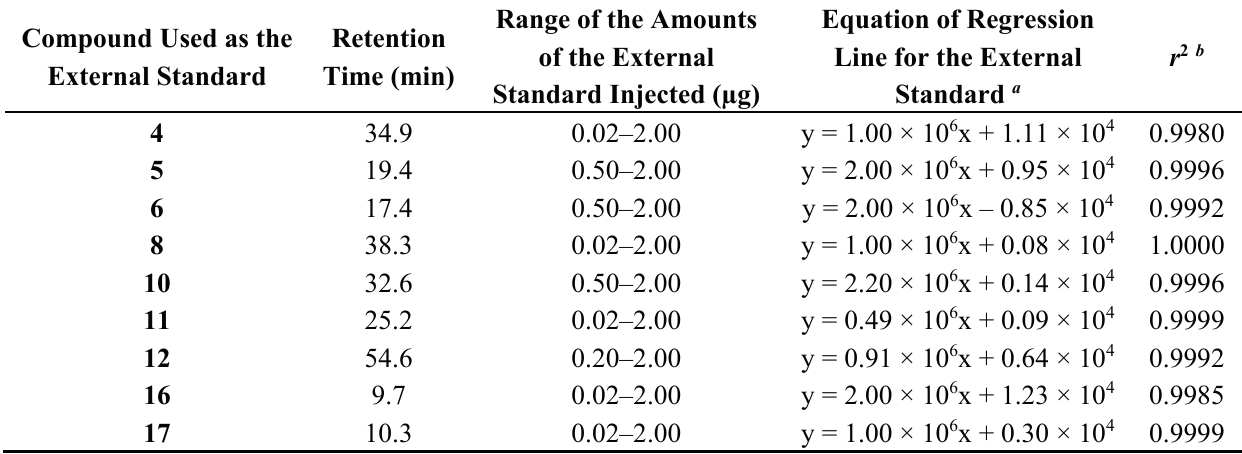
Table 4. Parameters for the quantitative analysis of the major constituents of P. corylifolia extract. Compound Used as